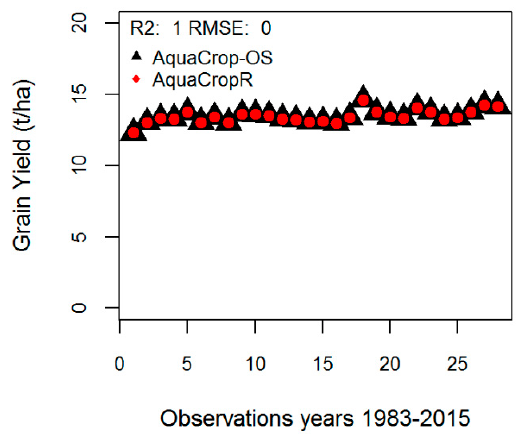
Figure 1. Simulated maize yields from 1983 to 2015. The test considers a scenario where irrigation is triggered once soil moisture falls below 70% depletion of total available water. R 2 and RMSE metrics show the fit between AquaCrop-OS and AquaCropR.